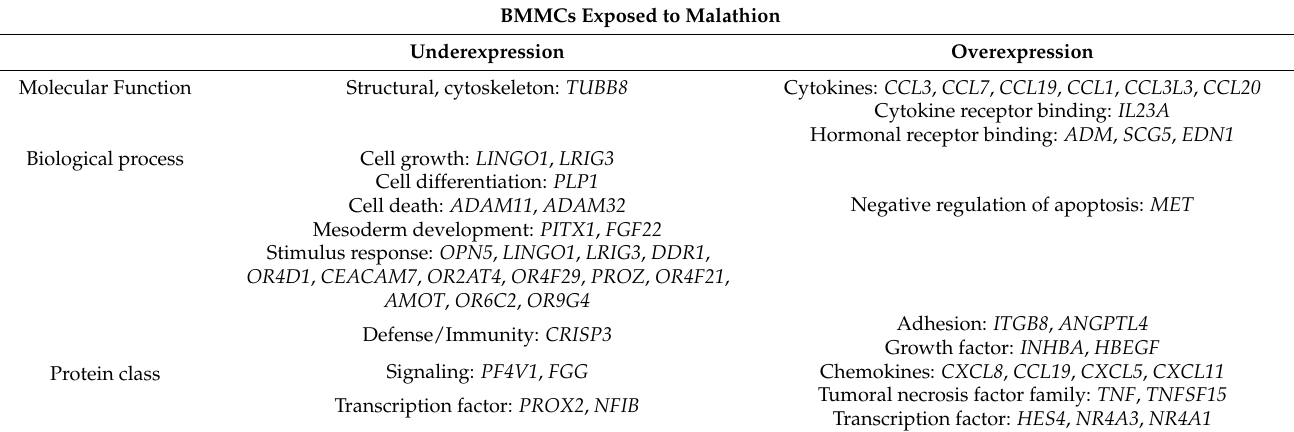
Table 1. Highlights of gene ontology analysis of the top and bottom 100 genes with over and underexpression in BMMCs exposed to malathion.